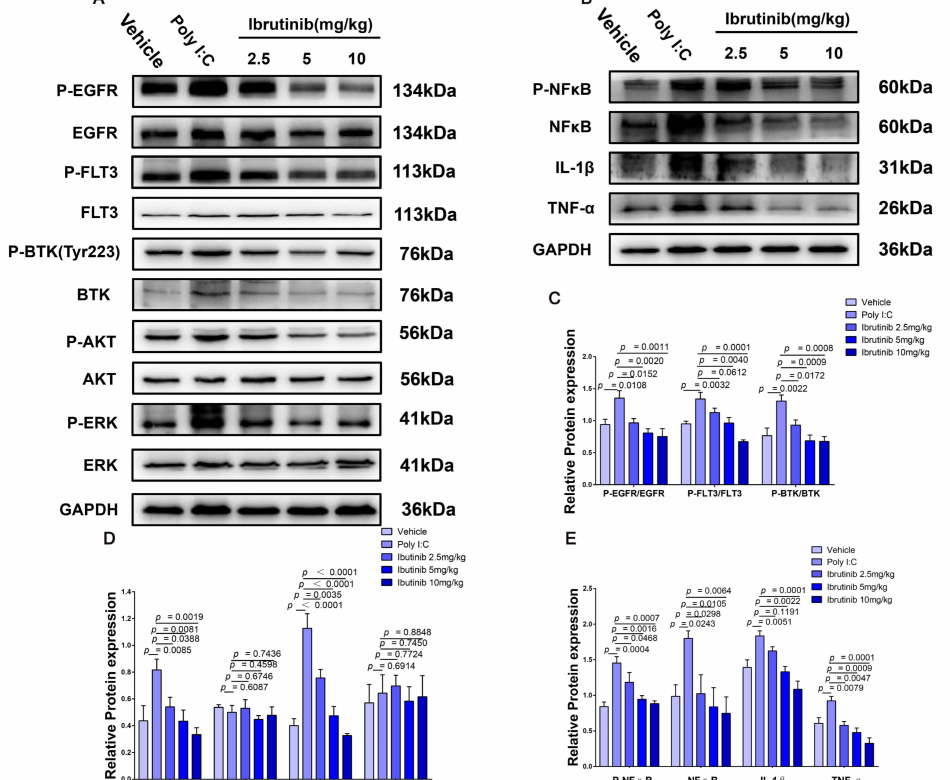
Figure 7. Effects of ibrutinib treatment on the BTK-, FLT3-, and EGFR-related signaling pathways during poly I:C-induced lung injury. ( A ) Protein levels of P-EGFR, EGFR, P-FLT3, FLT3, P-AKT, AKT, P-ERK, and ERK in the whole lung tissues of mice were assessed by Western blot analysis 48 h after poly I:C stimulation. ( B ) Protein levels of P-NF κ B, NF κ B, IL-1 β , and TNF- α in the whole lung tissues of mice were assessed by Western blot analysis 48 h after poly I:C stimulation. ( C – E ) Densitometric analysis of the relevant bands (P-EGFR, P-FLT3, and P-BTK normalized to EGFR, FLT3, and BTK). Values are shown as means ± SEM for n =